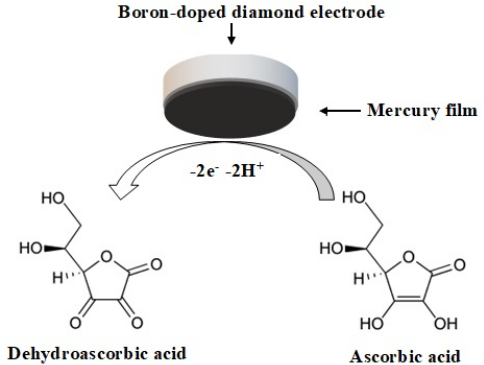
Figure 1. Electrochemical mechanism of ascorbic acid oxidation at the boron-doped diamond electrode modified with a mercury film.